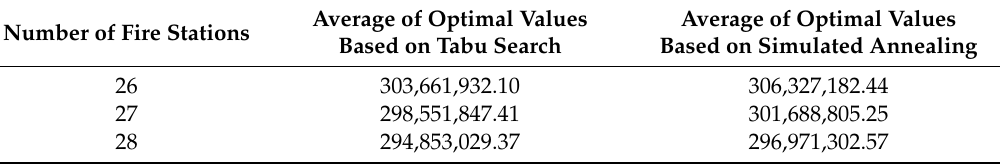
Table 23. Average of optimal values for 10 iterations of the model using both